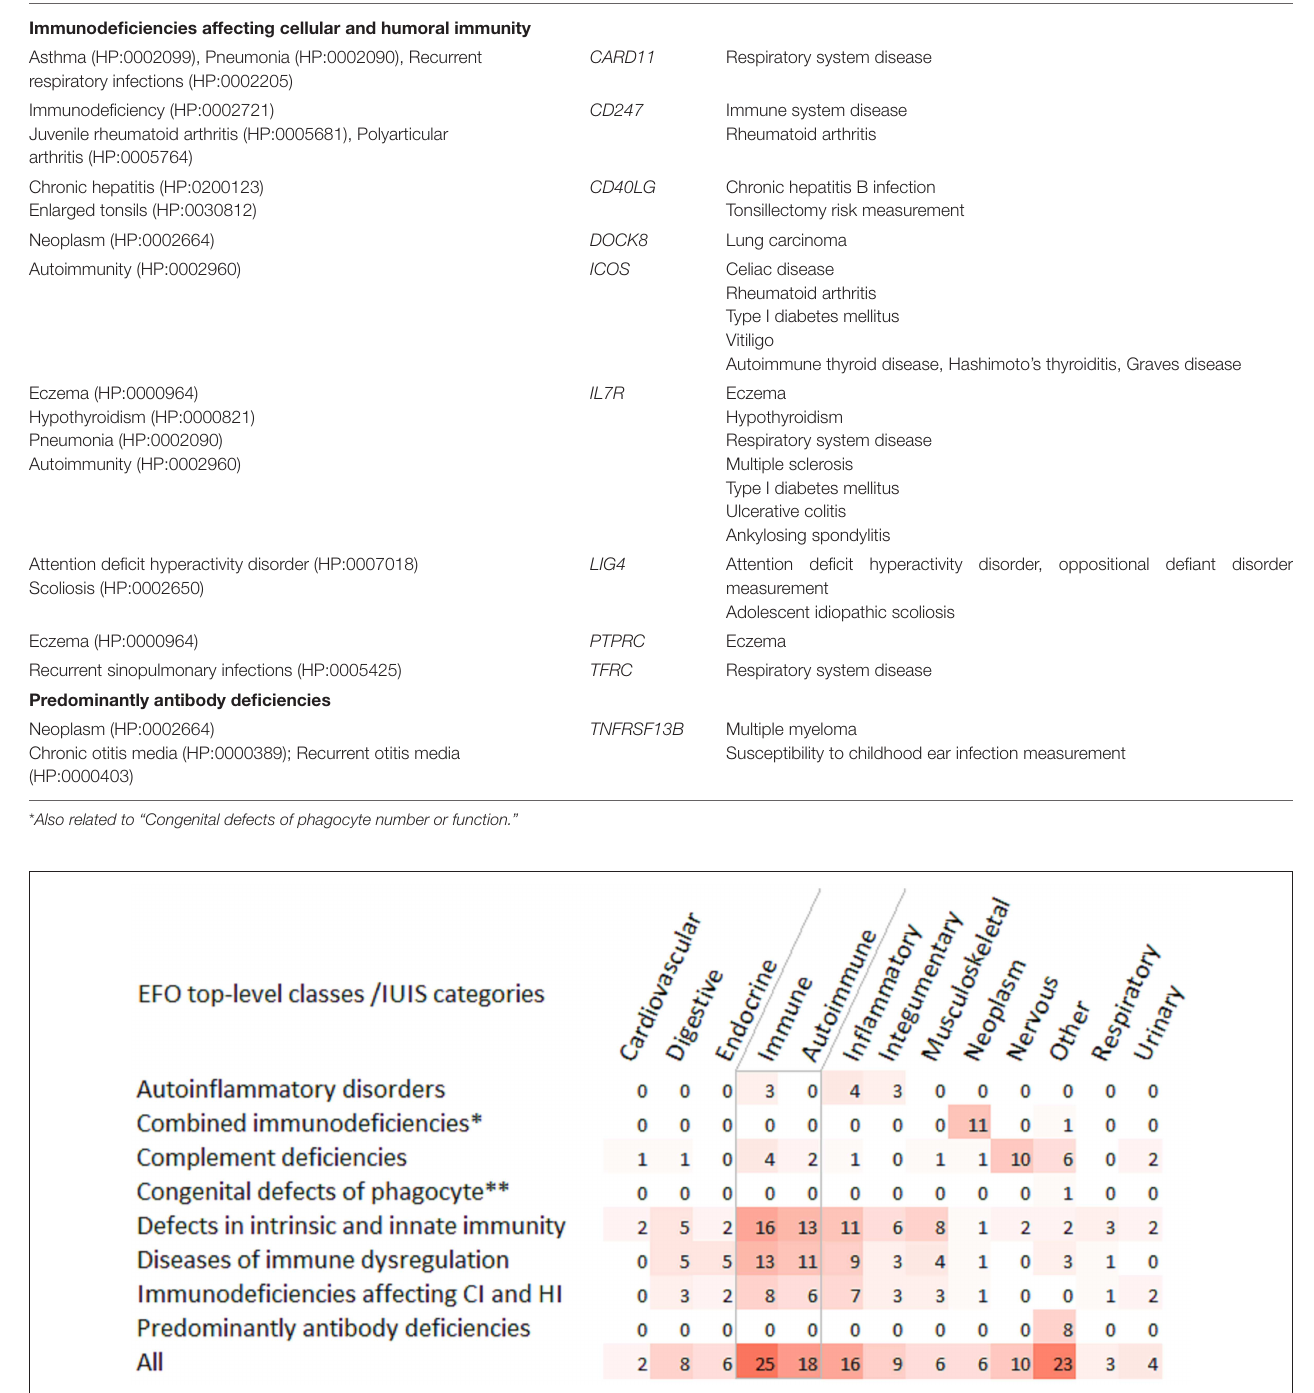
FIGURE 5 | Heat-map matrix for the GWAS Catalog 2019 gene-set enrichment analysis. The IUIS genes were analyzed for their overrepresentation in common diseases/traits. The diseases/traits were classified according the Experimental Factor Ontology (EFO).The number of overrepresented common diseases/traits was indicated for EFO top-level categories (X-axis) within the IUIS categories of diseases (Y-axis). In the group of immune diseases, the subgroup of autoimmune conditions is highlighted with gray boundaries.*Combined immunodeficiencies with associated or syndromic features; **Congenital defects of phagocyte number or function. CI, cellular immunity; HI, humoral